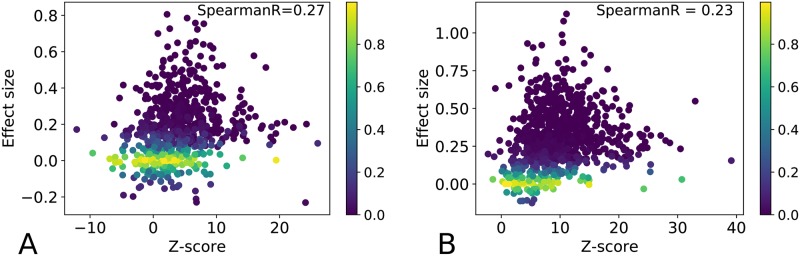
Relation between z-score (over-representation) and effect size (influence on the number of reviews) for accords of size two (panel A) and size three (panel B).The two variables seem to be at best weakly related. The colour of a point indicates the p-value of the permutation test as shown in panel on the right of each plot.